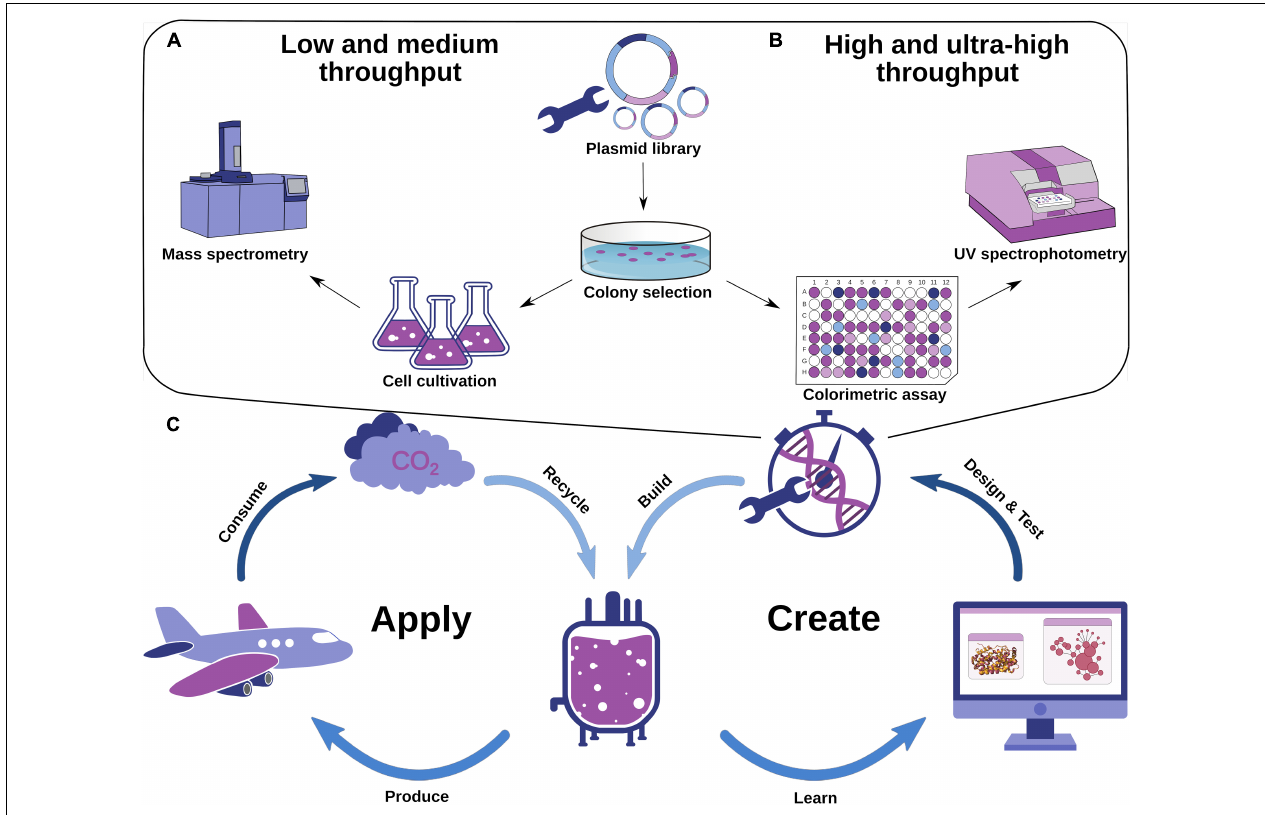
FIGURE 1 | Experimental protein engineering strategies and an idealized scheme for a design–test–build–learn cycle of optimizing enzymes using computation. (A) Exemplified workflow for low- and medium-throughput enzyme engineering strategies. (B) Exemplified workflow for high- and ultrahigh-throughput enzyme engineering strategies. (C) Design–test–build–learn cycle for industrial chemical production including computational methodology and production–consumption–recycling cycle of chemical usage. Promising enzyme variants are identified computationally, which leads to targeted experimental testing. The metabolic systems are then applied in microorganisms for industrial-scale production. The experimental implementation provides additional information for computational optimization. Consumption of chemicals as biofuels results in the release of CO 2 , which can be recycled by microorganisms in bioreactors to close the